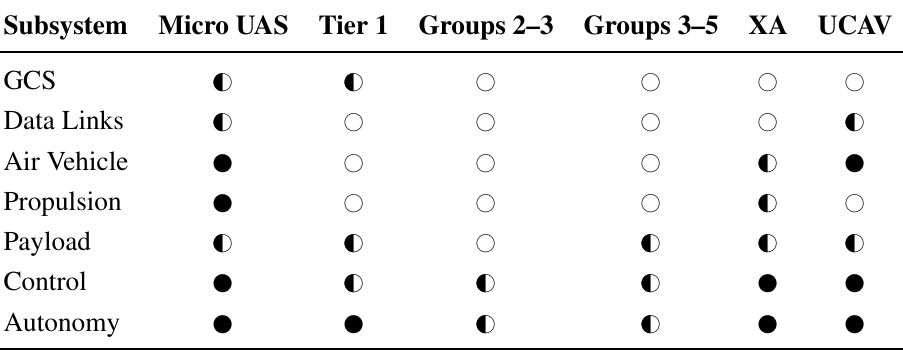
Table 2. indicates that Research will significantly enhance a technology in a class of Unmanned Aerial Systems (UAS), (cid:32) indicates that Research will have little real impact. (cid:35)